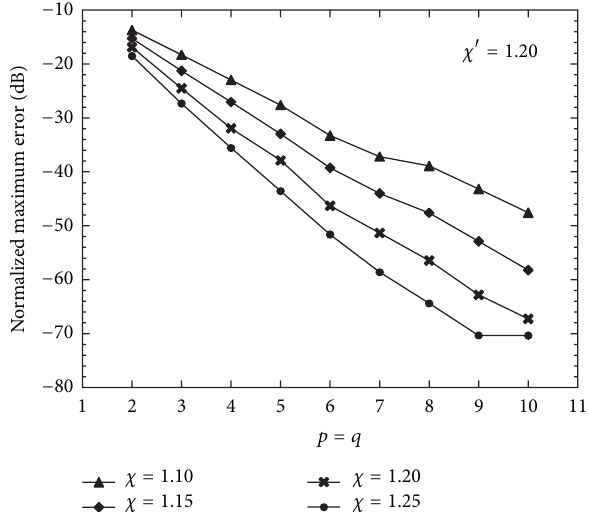
Figure 10: Normalized maximum errors in the reconstruction of 𝑉 .